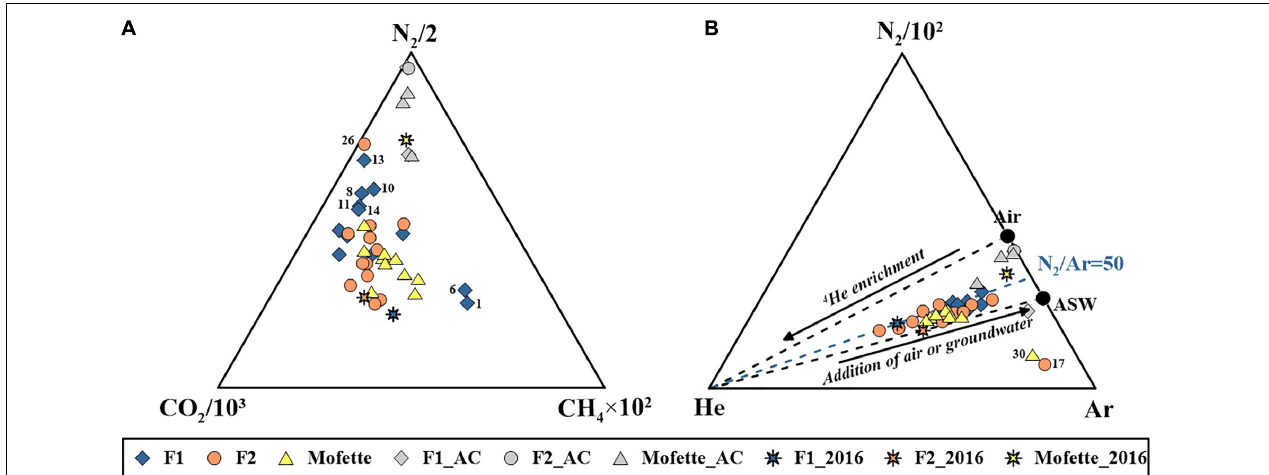
FIGURE 2 | (A) N 2 -CO 2 -CH 4 ternary diagram after Giggenbach et al. (1993) and (B) N 2 -He-Ar ternary diagram after Giggenbach et al. (1983) of the gas emitted in the HMF. The abbreviation _AC stands for air contamination, while data of samples collected during 2016 are from Bräuer et al.